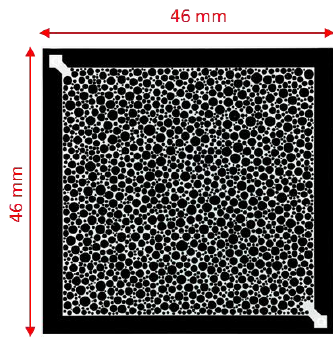
Figure 2. Micromodels used in this study. Scale of image is 46mm*46mm [21]. Table 2. Characteristics of micromodel and experiment used in this